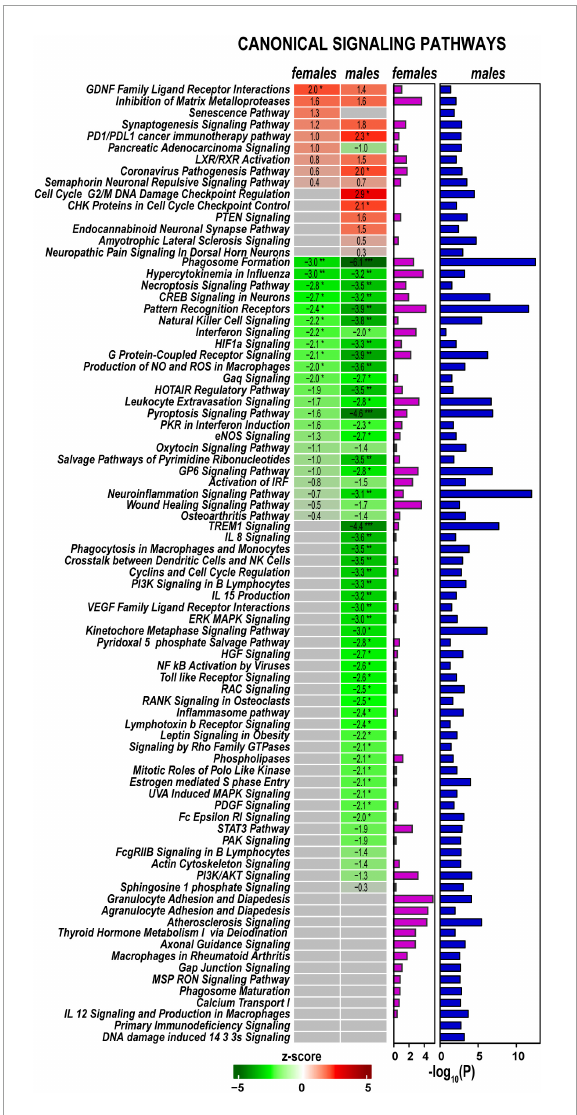
FIGURE4 Canonical signaling pathways demonstrate distinct regulation patterns in females and males. Canonical pathways were predicted in Ingenuity Pathway Analysis (IPA) and ranked by z-scores. Positive (red) and negative (green) z-scores indicate pathway up-regulation or down-regulation, respectively, according to the color scale. Fisher’s exact test p -values [–log 10 (P)] predicted for each canonical pathway are shown by purple (females) and blue (males) horizontal bars. Asterisks indicate significance *, z > 2.0 or z < − 2; **, z > 3.0 or z < − 3; ***, z > 4.0 or z < −